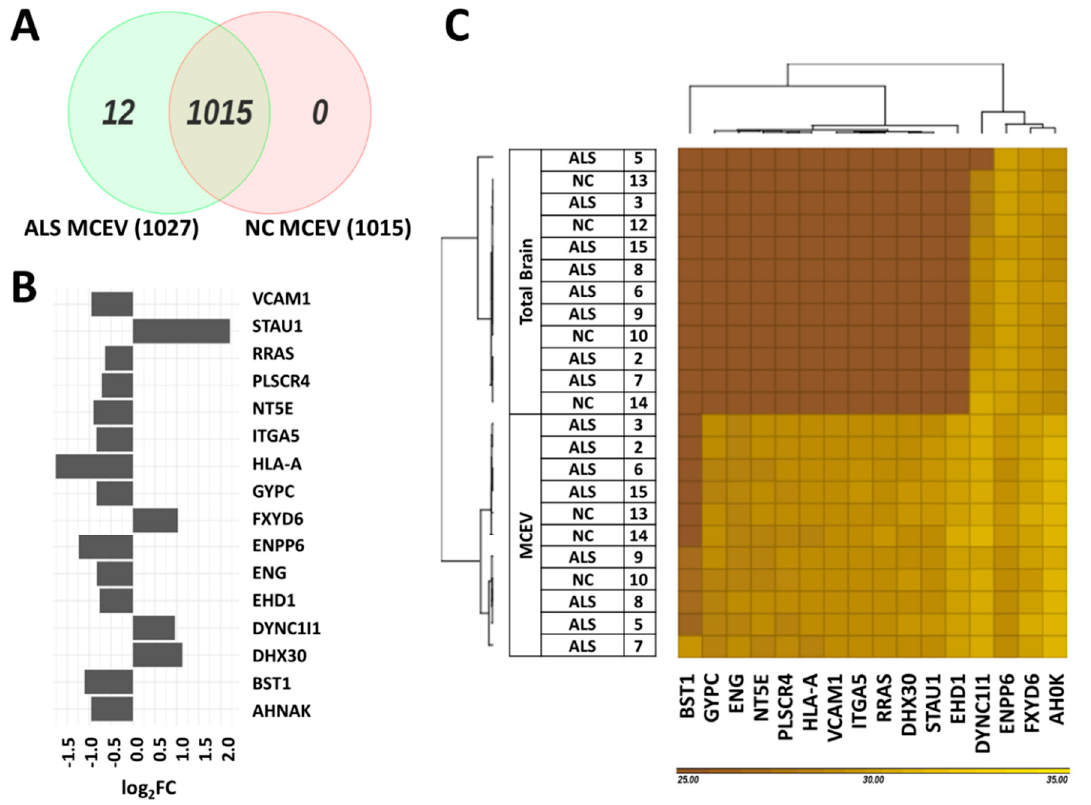
Figure 3. Di ff erentially packaged proteins between ALS and NC MCEVs. ( A ). Venn diagram depicting number of protein IDs present in ALS MCEVs and NC MCEVs. Cut o ff is 2 in NC samples and 3 in ALS samples = present. ( B ). Bar graph showing statistically significant di ff erentially packaged proteins in ALS MCEVs compared to NC MCEVs. LFQ-normalised and weighted for di ff erential expressed analysis (MaxLFQ values are presented in Supplementary Table S2). ALS MCEVs n = 7 and NC MCEVs n = 3. ( C ). Heat map depicting relative abundancy of statistically significant enriched proteins in MCEVs compared to TBs.